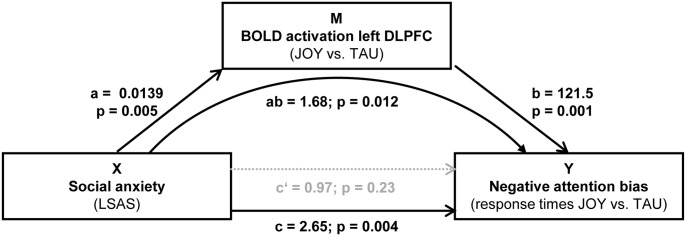
Mediation of the impact of social anxiety on the negative attention bias during laughter perception through cerebral activation patterns of the prefrontal cortex.X = independent variable (i.e., LSAS-SR scores), Y = dependent variable (i.e., response time differences JOY – TAU), M = mediator variable (i.e., differential cerebral activation JOY – TAU in the left DLPFC); a = effect of X on M; b = effect of M on Y partialling out X; c = total effect of X on Y; c’ = direct effect of X on Y; ab = indirect effect of X on Y through M. p value of ab refers to the Sobel test. Continuous arrows indicate significant effect while non-significant effects are symbolized by dashed arrows. Significance of the results remains unaltered when statistically controlling for the influence of general anxiety (STAI).